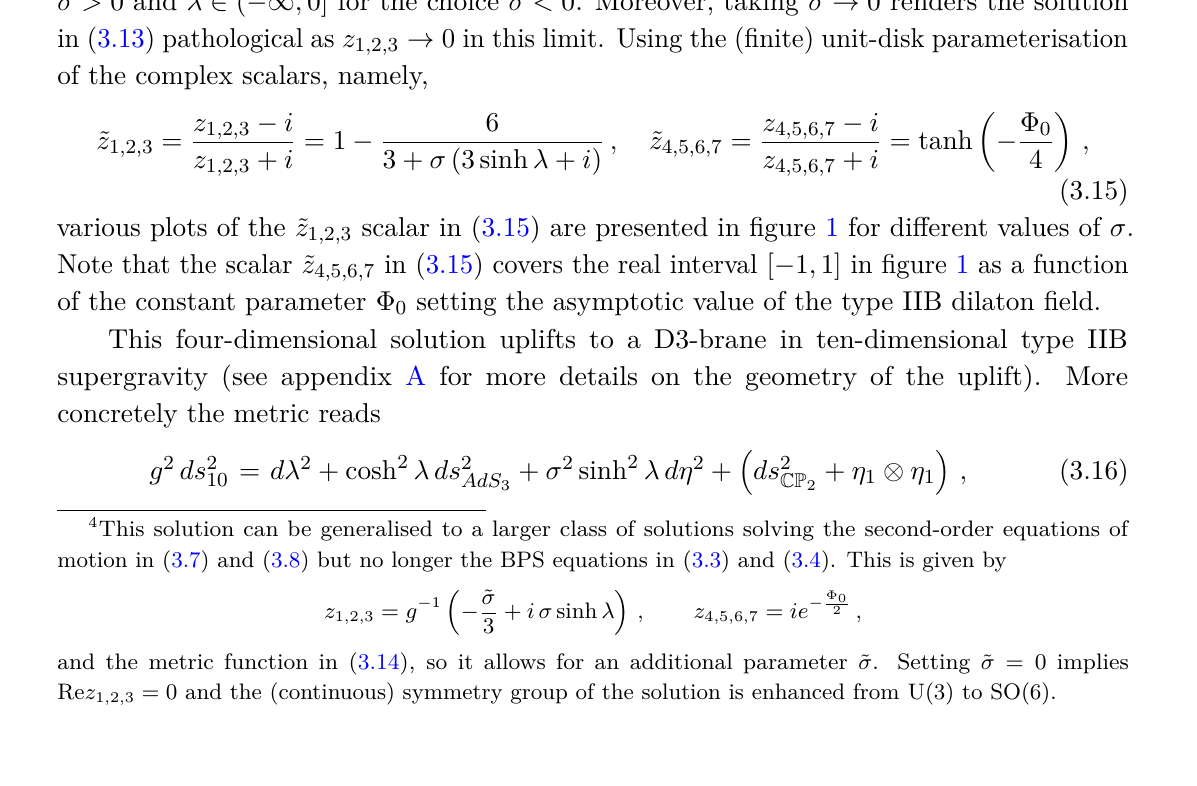
Figure 1 . Parametric plot of the D3-brane solution at c = 0 using the unit-disk parameterisation of the complex scalars ˜ z and ˜ z in (3.15). On the left plot, the black point at ˜ z 1 , 2 , 3 4 , 5 , 6 , 7 reached at the asymptotic values λ → ∞ (red curves with σ > 0 ) and λ → −∞ (blue curves with σ < 0 ). The singular value σ = 0 corresponds to the straight line starting at ˜ z 1 , 2 , 3 = − 1 . On the right plot, different points belonging to the black line in the real axis correspond to different values of the D3-brane constant parameter Φ 0